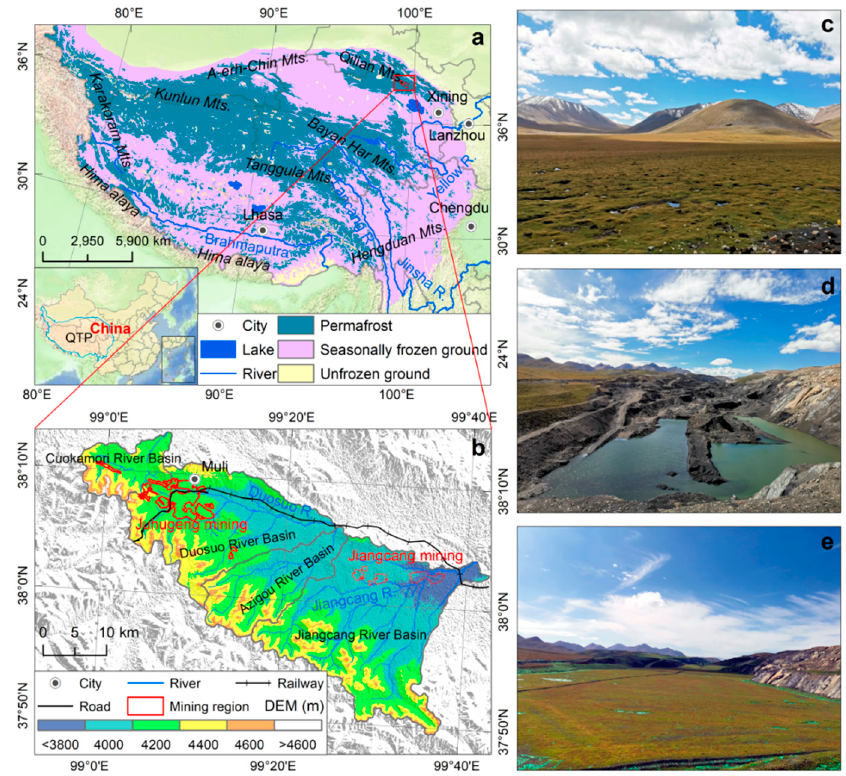
Figure 1. Overview of the study area. ( a ) Spatial distribution of permafrost region in the Qinghai-Tibet Plateau (QTP) (the permafrost map is from [45]); ( b ) digital elevation model (DEM) of the study area; ( c ) natural landscape in the neighborhood of the mines; ( d ) waterlogged open-pit mine; and ( e ) demonstration area showing the mining restoration and